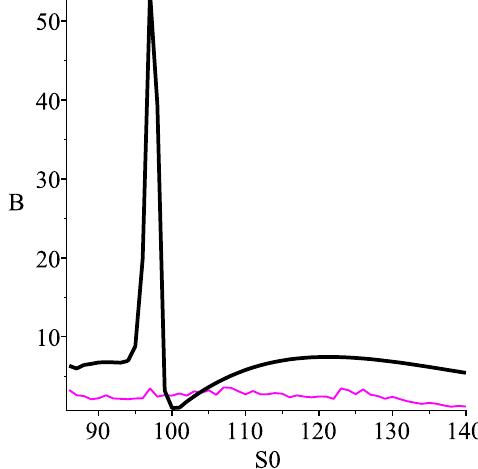
Figure 3. The value of B as a function of S 0 , for Joshi’s original split tree (bold) and the the optimal split tree near τ